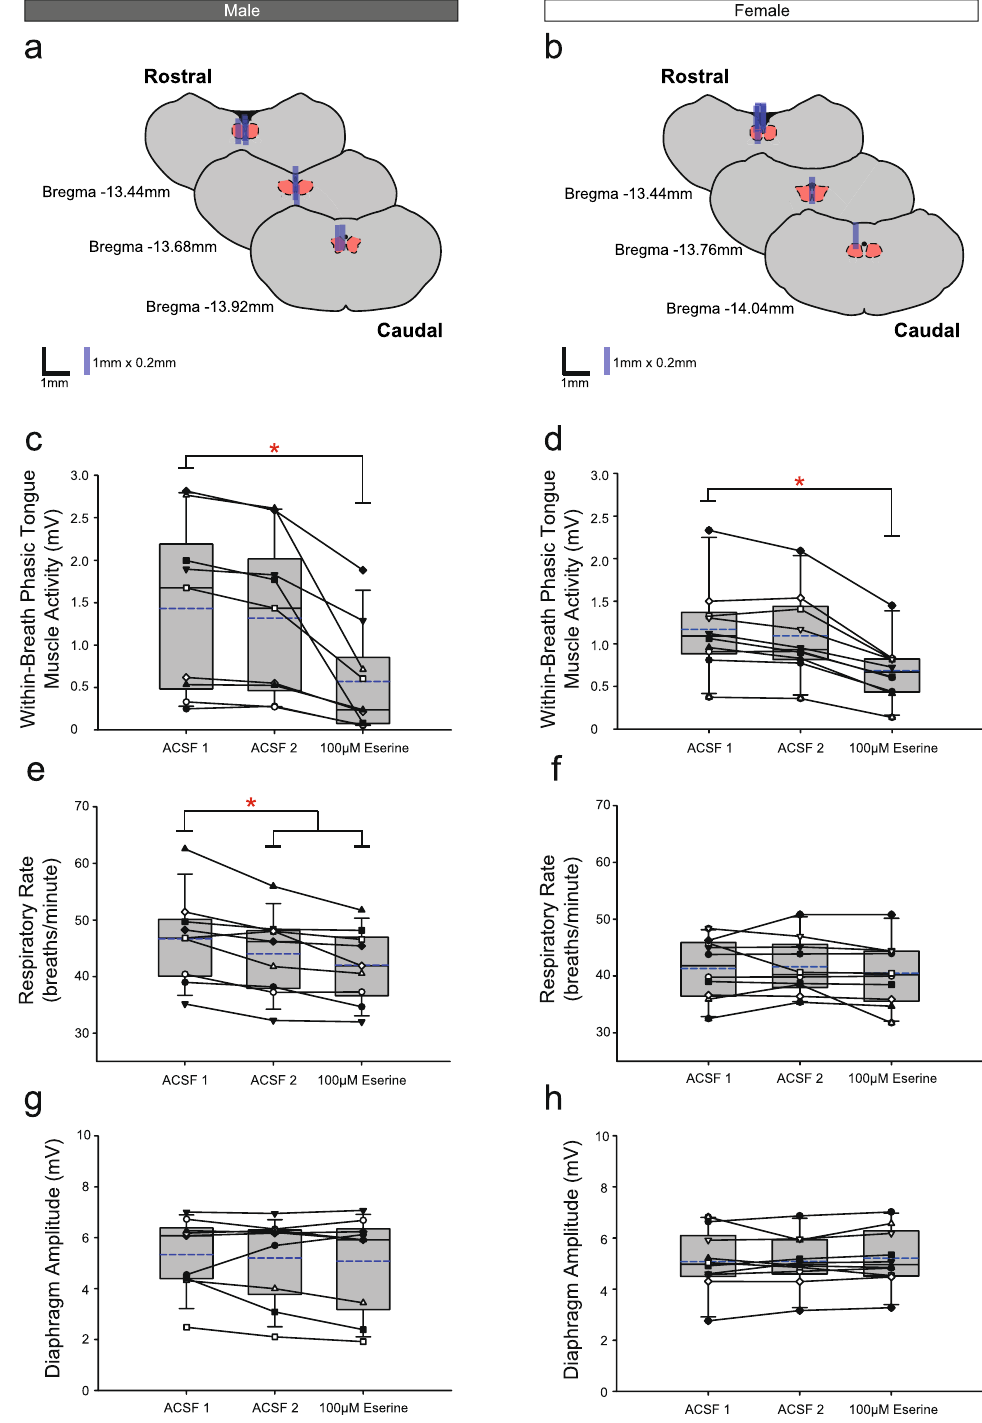
Figure 3. Group data from Protocol 1.1 : Microperfusion of 100 μM eserine into the HMN (left column: male, n = 9; right column: female, n = 10). Schematic representations of coronal sections of medulla illustrating the distribution of probe sites across all experiments ( a , b ). Drawn to scale, the blue rectangles represent reconstruction of the sites of the microdialysis probes; overlap obscures some of the individual probe sites. Box and whisker plots show individual and group data (median [dashed line], mean [solid line] and 25th and 75th percentiles) for within-breath phasic tongue muscle activity ( c , d ), respiratory rate ( e , f ), and diaphragm amplitude ( g , h ). Each animal is indicated by a different symbol. *, indicates p < 0.05 compared to baseline ACSF